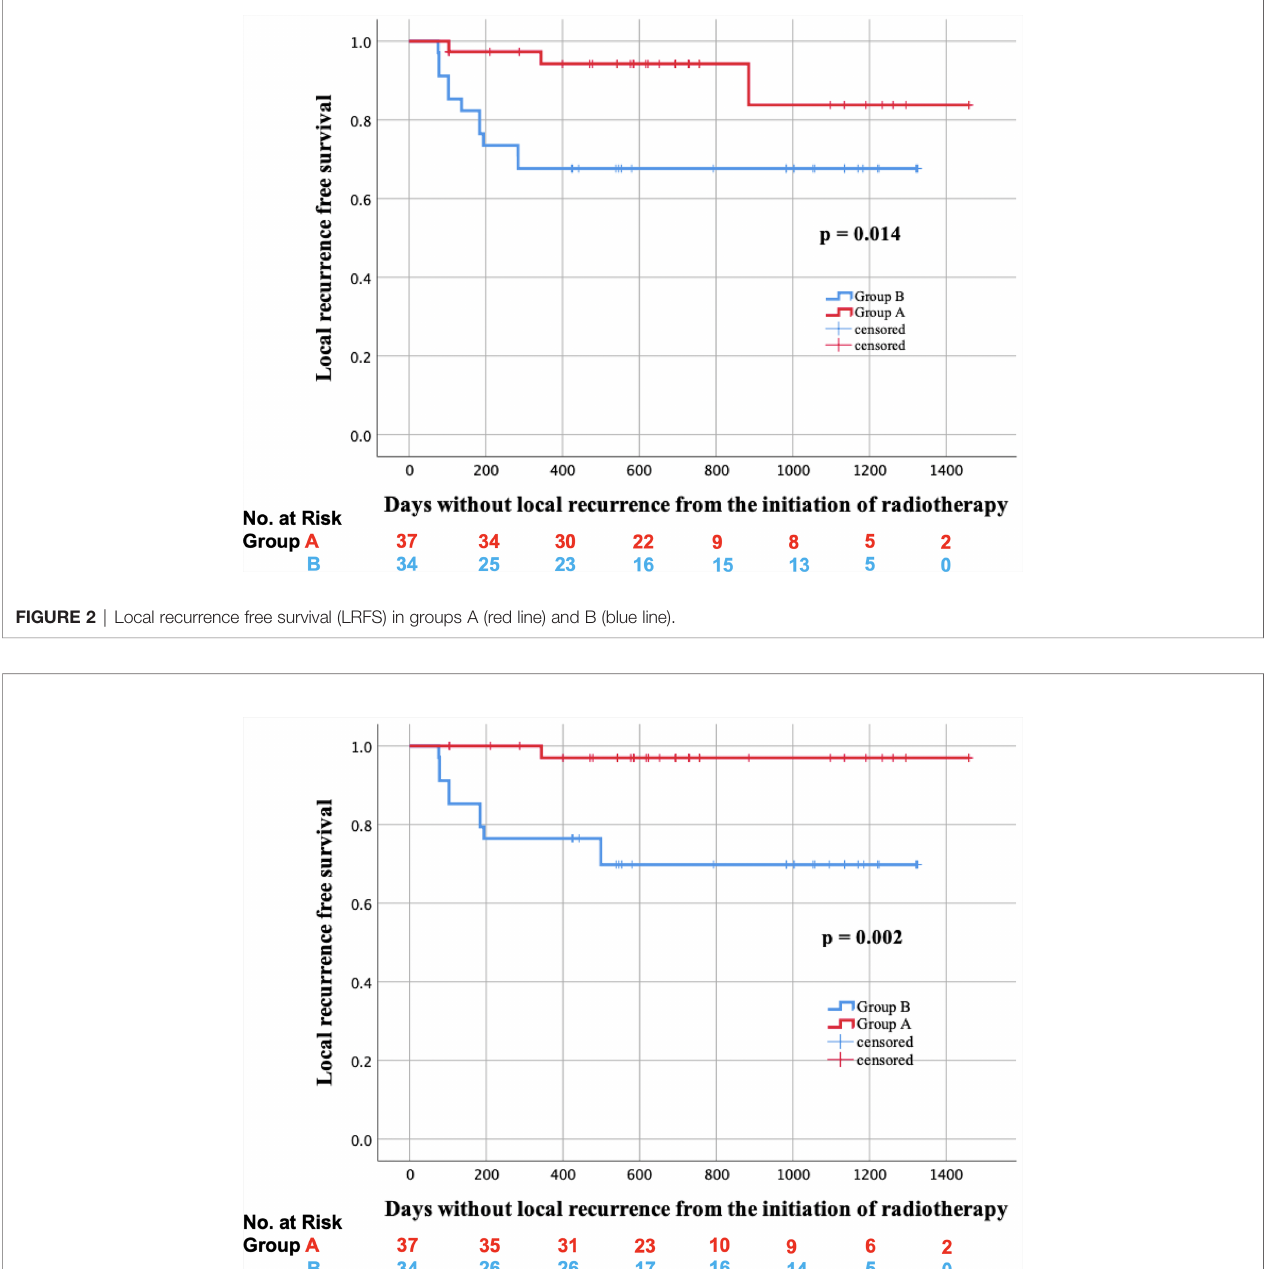
FIGURE 3 | Local recurrence free survival considering salvage surgery (tLRFS) in groups A (red line) and B (blue